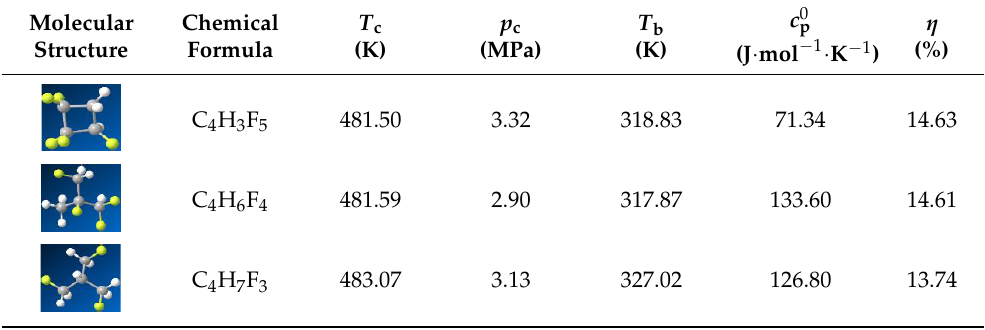
Table 11. Thermophysical properties and thermal efficiency of candidates at 523.15K heat source. Molecular Structure